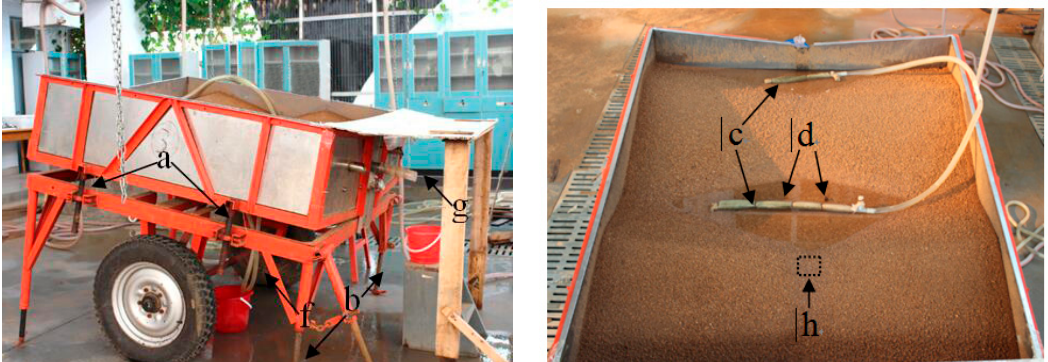
Figure 2. Experimental plot for adjusting row grade and field slope simultaneously by rotating a screw (a) and (b), and creating seepage condition by supplying water with a flow rate of 3 L min − 1 to the furrows where the water level was controlled by pipes (d). a, screw for adjusting row grade; b, screw for adjusting field slope; c, pipes for supplying water; d, pipes for adjusting the water level 1 cm lower than the concave spot at the ridge (h); f, pipes for redundant water collection; g, outlet for collecting seepage and surface runoff.